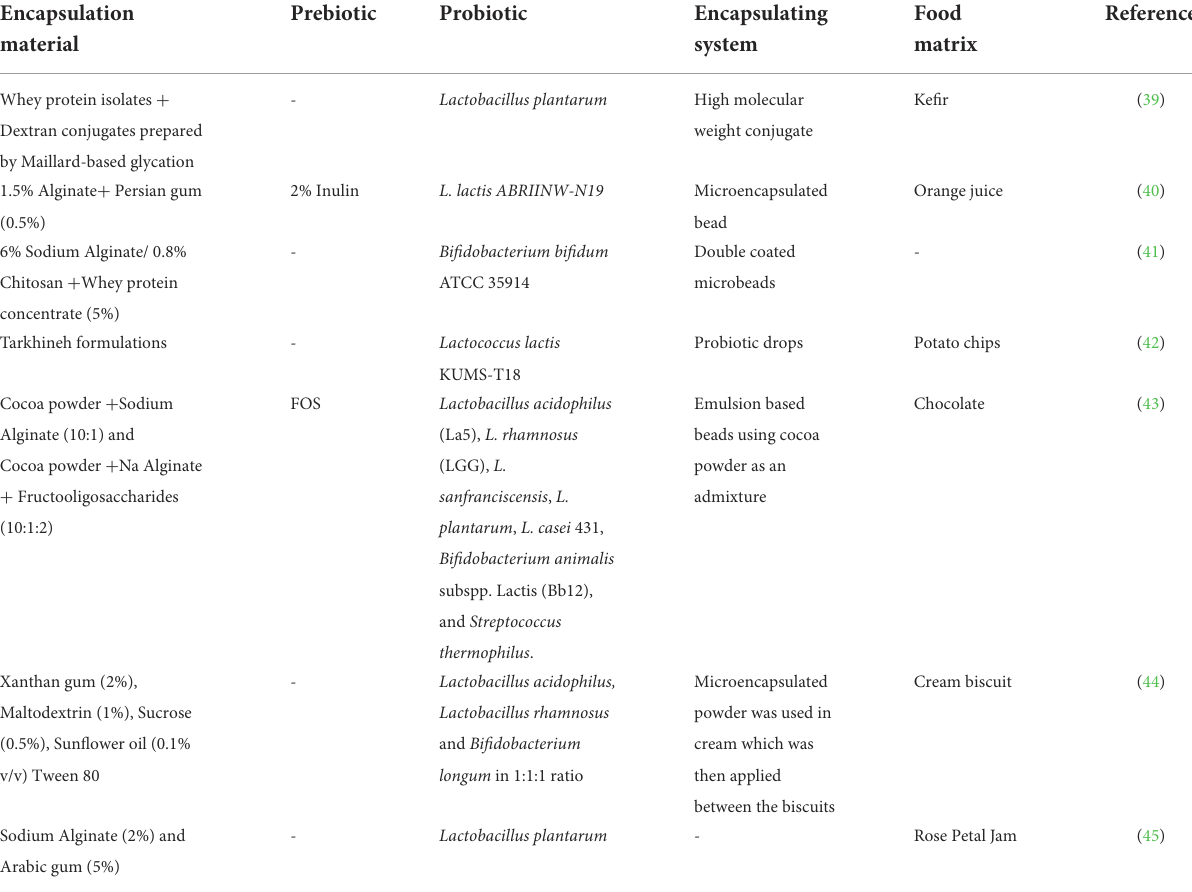
TABLE 2 Examples of various encapsulating materials and its applications in food